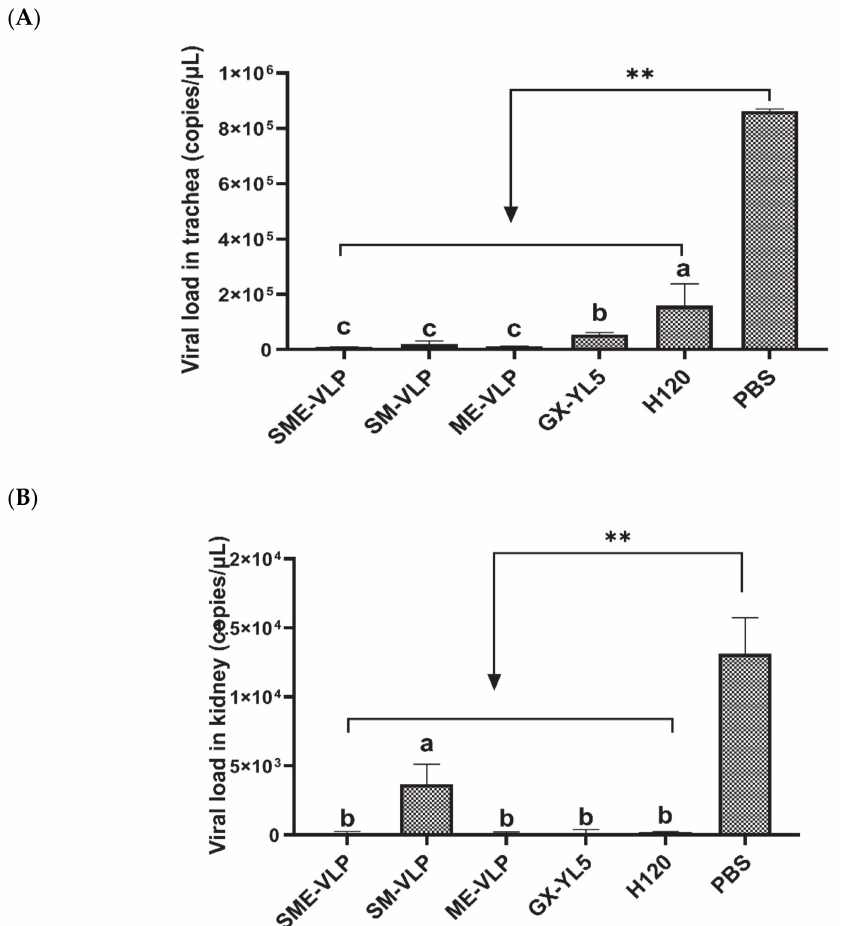
Figure 11. Viral loads in tracheas and kidneys. IBV RNA levels in tracheas and kidneys were evaluated at 5 days post-challenge (dpc). ( A ) Viral loads in tracheas. ( B ) Viral loads in kidneys. Letters (a–c) indicate significant differences among vaccinated groups ( p < 0.05). ** indicates p < 0.01 between vaccinated and nonvaccinated groups. ( n = 10 chickens/group.)